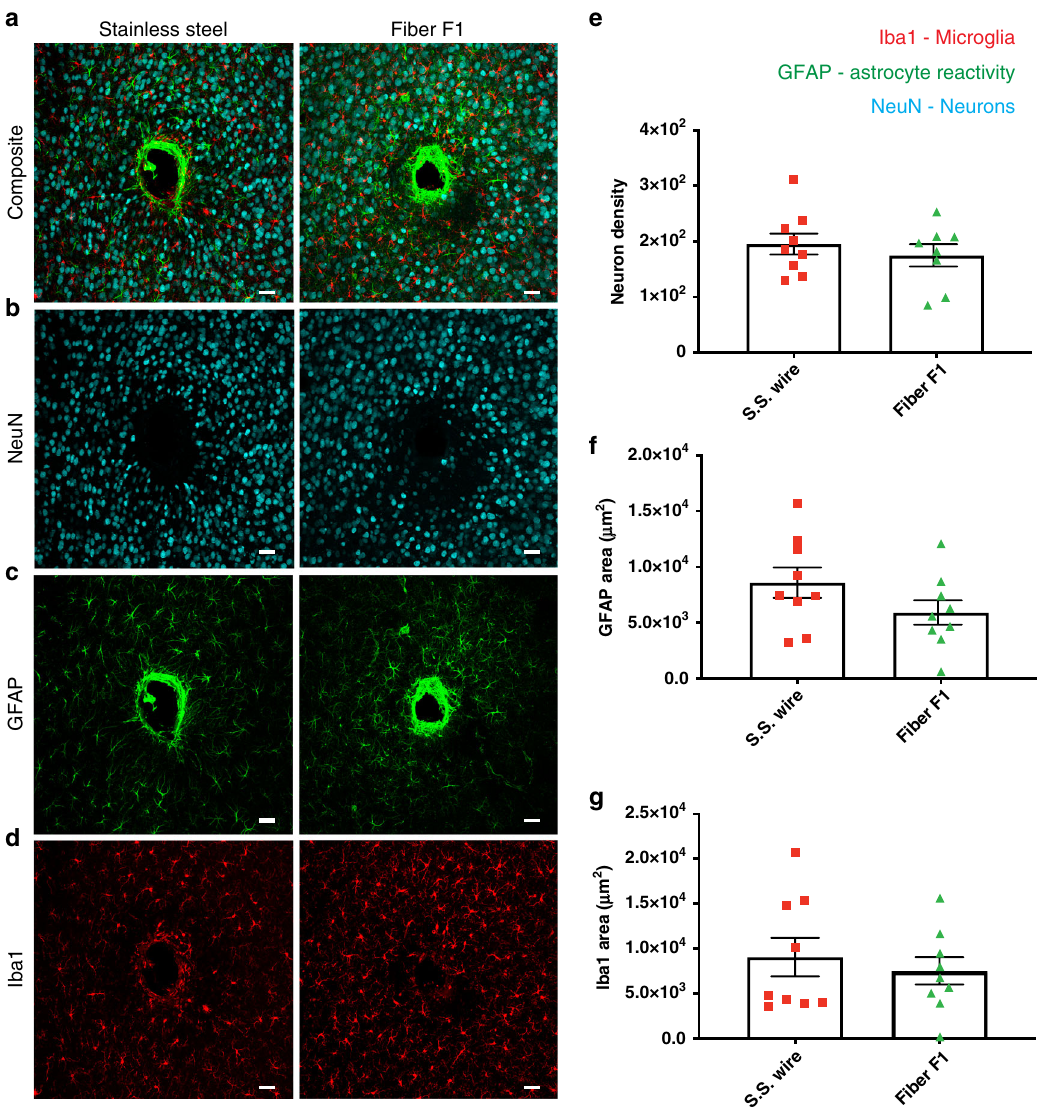
Fig. 6 Biocompatibility study of the functional fi ber probes (Fiber F1) and stainless steel wire. a – d Immunohistochemical comparison of tissue reaction to chronically implanted Fiber F1 ( n = 3) and conventional stainless steel wire ( n = 3) after four-week implantation. Neurons were labeled with NeuN (cyan), astrocytes with GFAP (green), and microglia with Iba1 (red). (Maximum intensity projections of 50 optical sections covering entire slice thickness taken at the implantation site). b , e Neuron density, calculated by counting NeuN labeled neurons, was not signi fi cantly different between the groups. c , f Astrocyte and microglia d , g reactivity, measured as the area of GFAP- or Iba1-positive cells respectively, were not signi fi cantly different between groups. Signi fi cance was determined by student ’ s t -test. Error bars on bar graphs re fl ect the standard deviation. Two-to-three brain slices from each mouse ( n = 3) per experimental group were used for immunohistochemical analysis. Representative images were chosen to re fl ect the mean value of quantitative data. (Scale bar: 40 μ